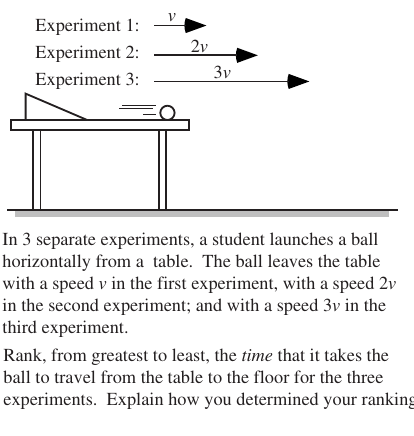
FIG. 1. Projectile question: speed cuing. FIG. 2. Projectile question: distance